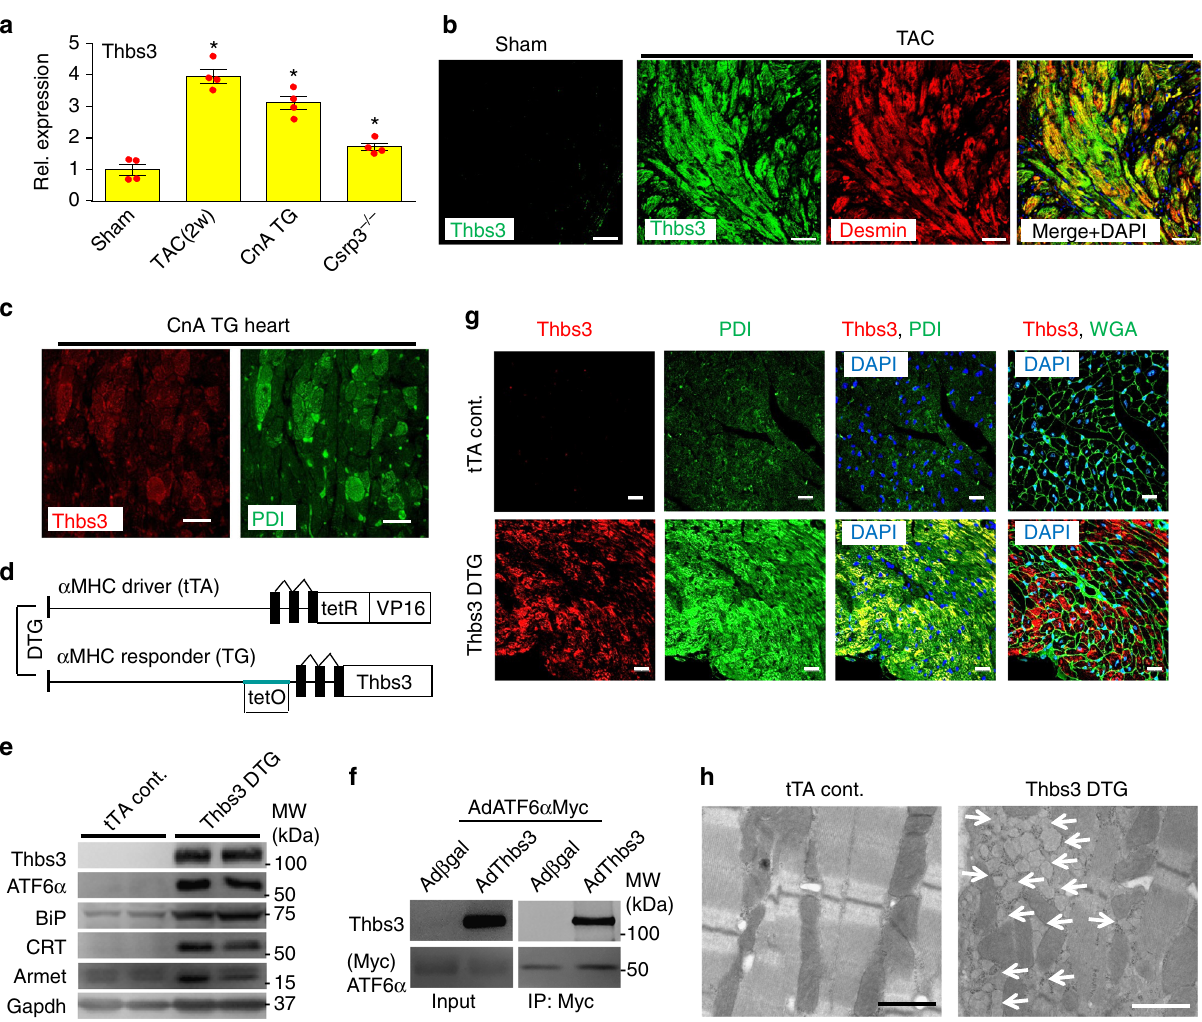
Fig. 1 Thbs3 is expressed in the diseased heart and induces an adaptive ER stress response. a Quantitation of relative protein expression from Western blots for Thbs3 from heart tissue of mice that were sham-operated, subjected to 2 weeks of TAC, that contain the activated calcineurin A transgene (CnA) or that lack the Csrp3 gene. * P < 0.05 vs sham by one-way ANOVA and Turkey multiple comparisons test. Results are from four experiments and error bars represent + / − SEM. b Immunohistochemistry for Thbs3 protein (green), desmin (red) and both merged with DAPI (blue) sham or TAC-operated hearts 12 weeks later. Scale bars are 10 μ m. c Representative immunohistochemistry for Thbs3 (red) and PDI (green) from CnA transgenic hearts at 8 weeks of age. Scale bars are 10 μ m. d Schematic diagram depicting the inducible bi-transgenic system regulated by tetracycline for inducible overexpression of Thbs3 in the heart. e Representative Western blots for Thbs3, the nuclear form of ATF6 α , Armet, BiP, calreticulin (CRT) and Gapdh from hearts of tTA control and Thbs3 DTG mice. f Western blots for Thbs3 from neonatal rat ventricular myocytes (NRVM) infected with recombinant adenovirus expressing Myc-tagged ATF6 α and β gal or Thbs3. Input control and immunoprecipitation (IP) of Thbs3 with Myc-tagged ATF6 α are shown. g Representative immunohistochemistry for Thbs3 (red), WGA (green) or PDI (green) and DAPI (blue) from hearts of tTA control and Thbs3 DTG mice. Scale bars are 10 μ m. h Transmission electron microscopy (EM) of heart sections from tTA control and Thbs3 DTG mice. The white arrows show expanded ER and vesicles only in Thbs3 DTG hearts. Scale bars are 1 μ